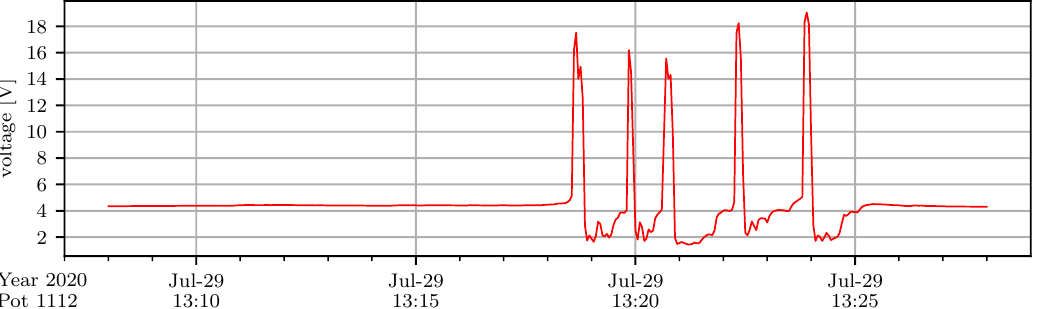
Figure 1. Example of voltage behaviour during an anode effect (AE) with four restarts from train dataset.